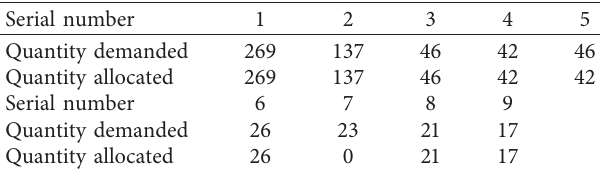
Table 9: Hospital demand and allocation of red blood cells in period t � 1 (unit: U).